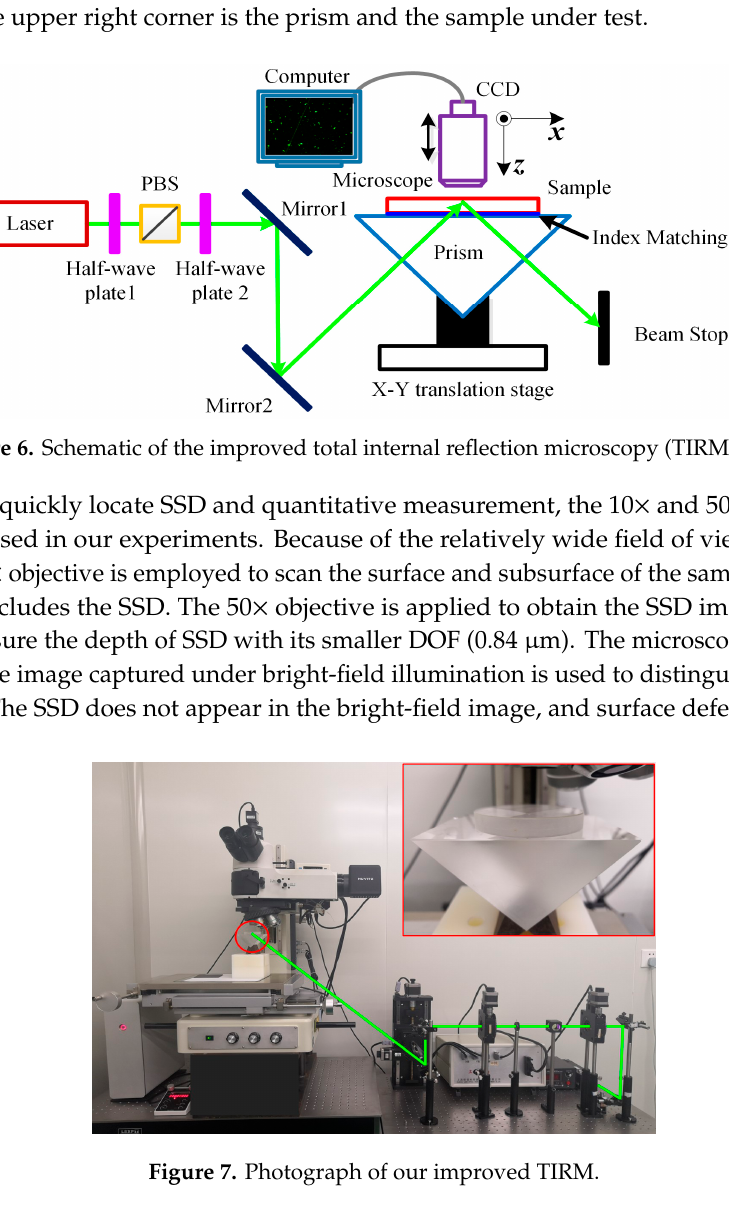
Figure 5. Distribution of the standing wave field.